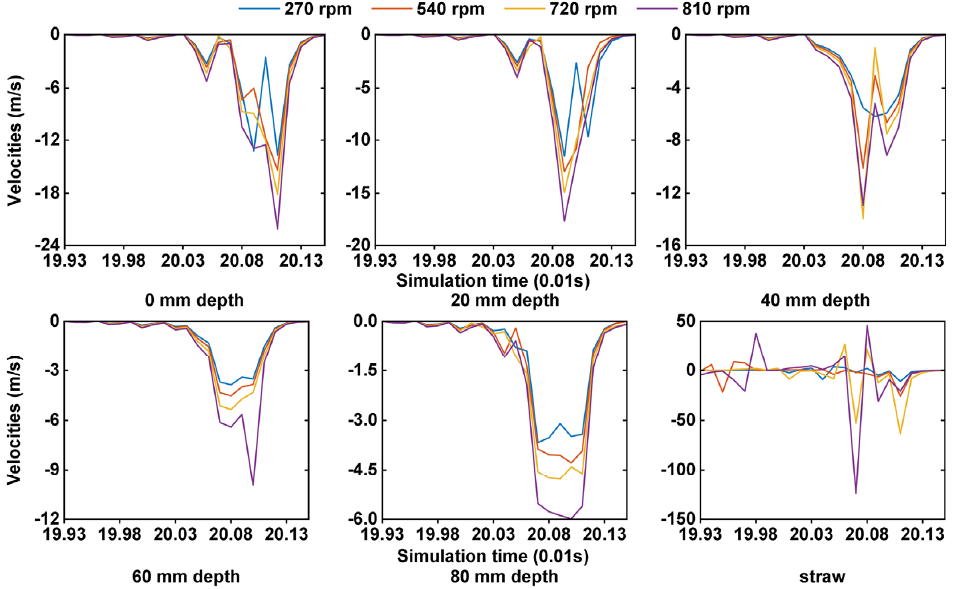
Figure 12. Longitudinal velocities of soil particles at di ff erent depths and surface straws at di ff erent rotary speeds. rotary